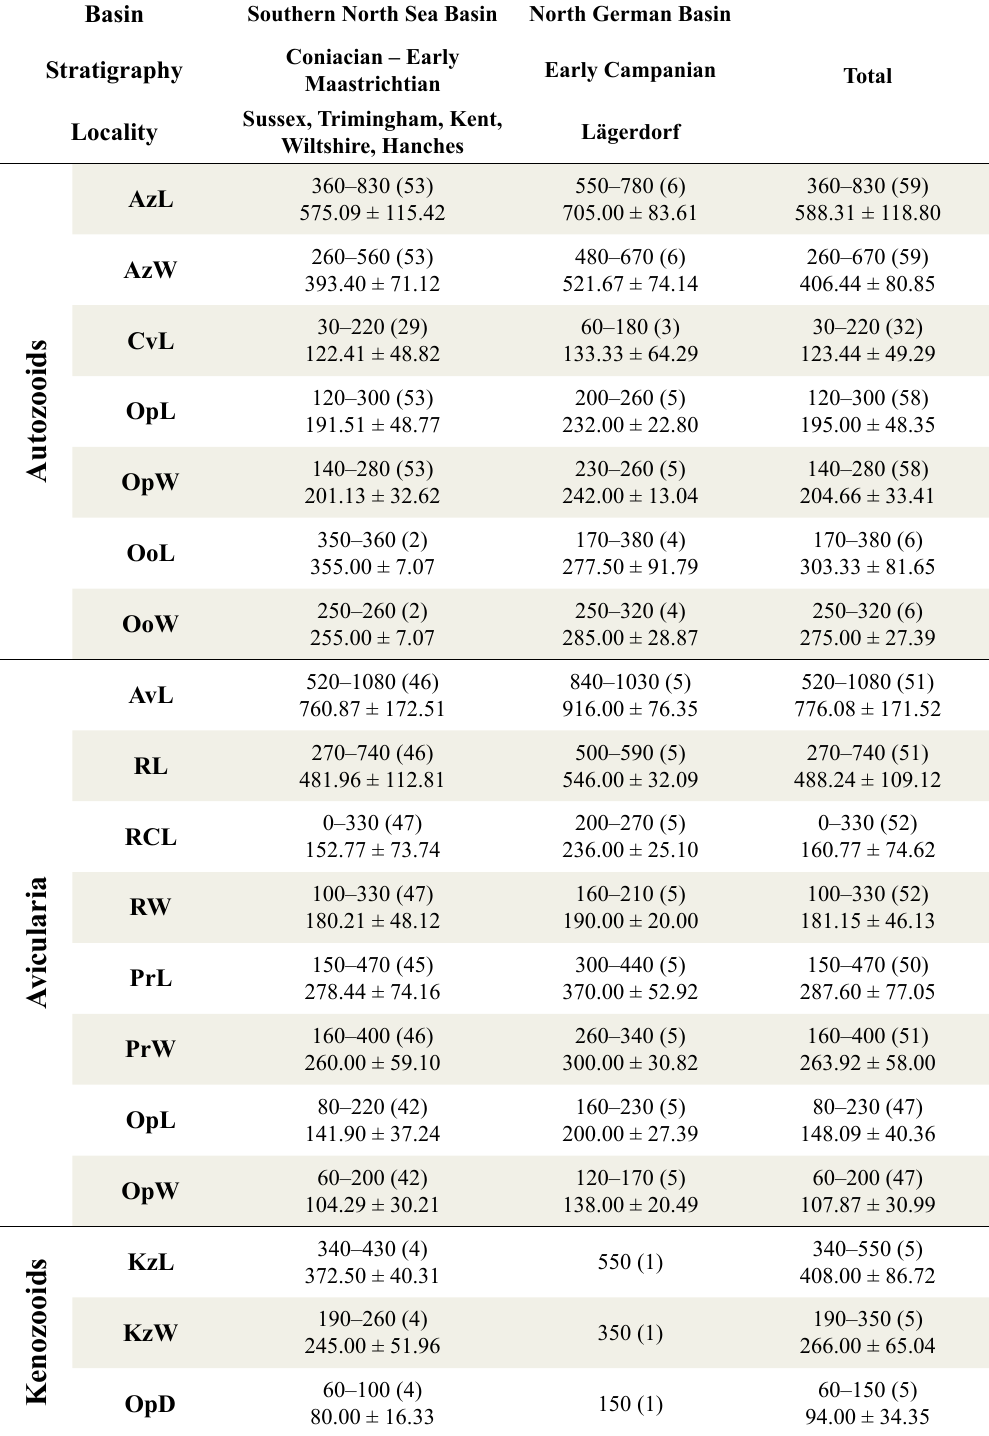
Table 3. Summary of measurements of Rhagasostoma minuens Brydone, 1936. For each parameter the range is given with the number of measurements in brackets. The arithmetic mean is given ± standard deviation. All measurements in